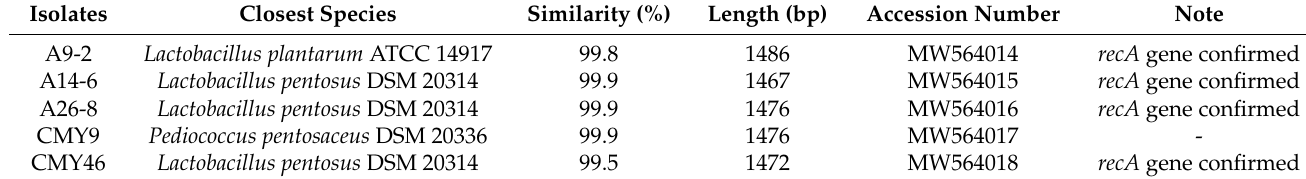
Table 2. Molecular identification of LAB isolates by 16S rRNA gene sequence analysis.